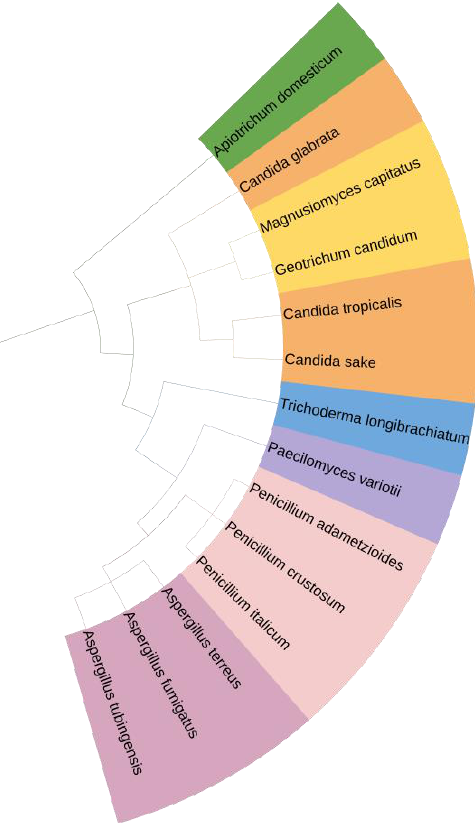
Figure 1. Phylogenetic tree of identified fungal species (visualization by iTOL reprinted/adapted with permission from Letunic and Bork [38], 2021, Oxford University Press).